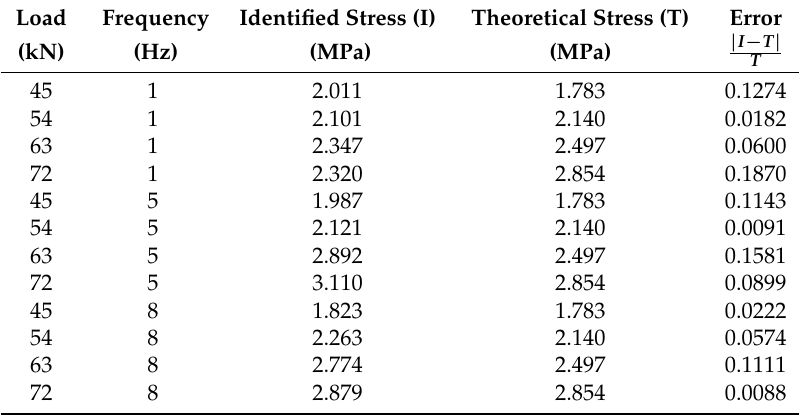
Figure 3. The voltage signals and identified results of the wheel tracking test. ( a ) Voltage signals of No .2 PZT chip at four different depths; ( b ) Voltage signals of No .1–4 PZT chips at same depth 10 mm; ( c ) Identified results of No .2 PZT chip at four different depths; ( d ) Identified results of No .1–4 PZT chips at same depth 10 mm. Table 3. The identified load results of No.1 PZT chip in the MTS